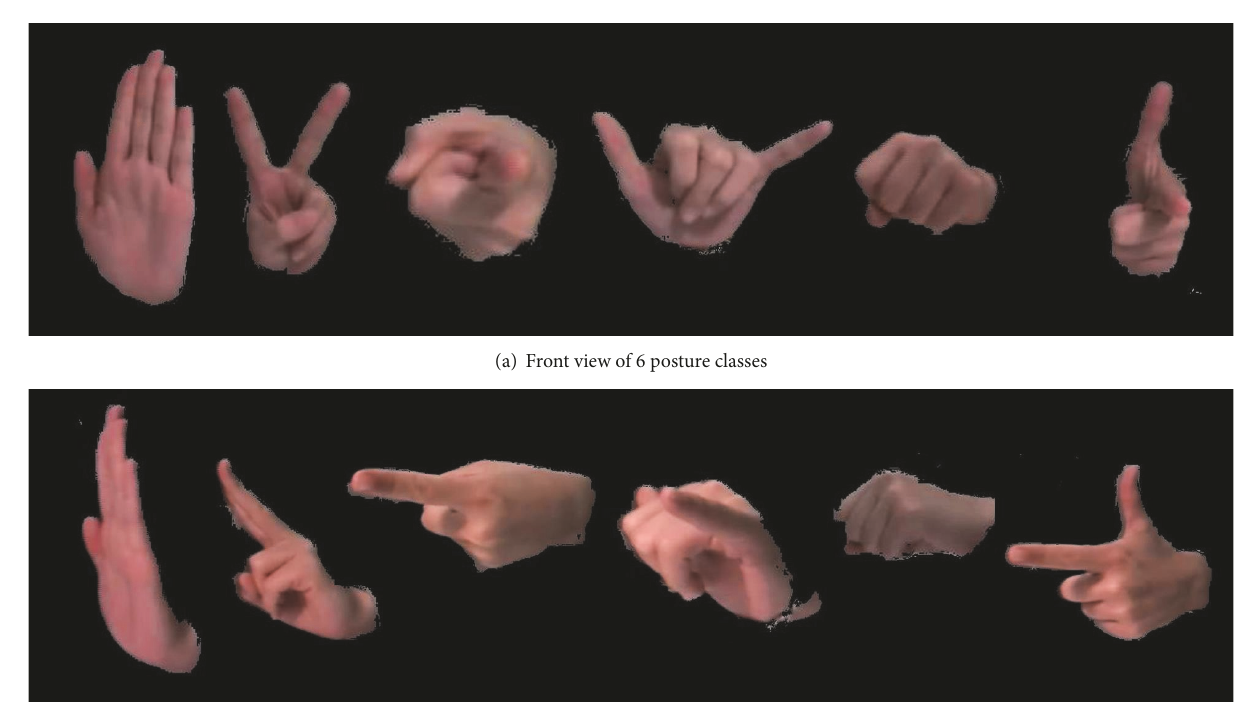
Figure 24: The pipeline of generating histogram of visual word for each image based on the detected feature points.